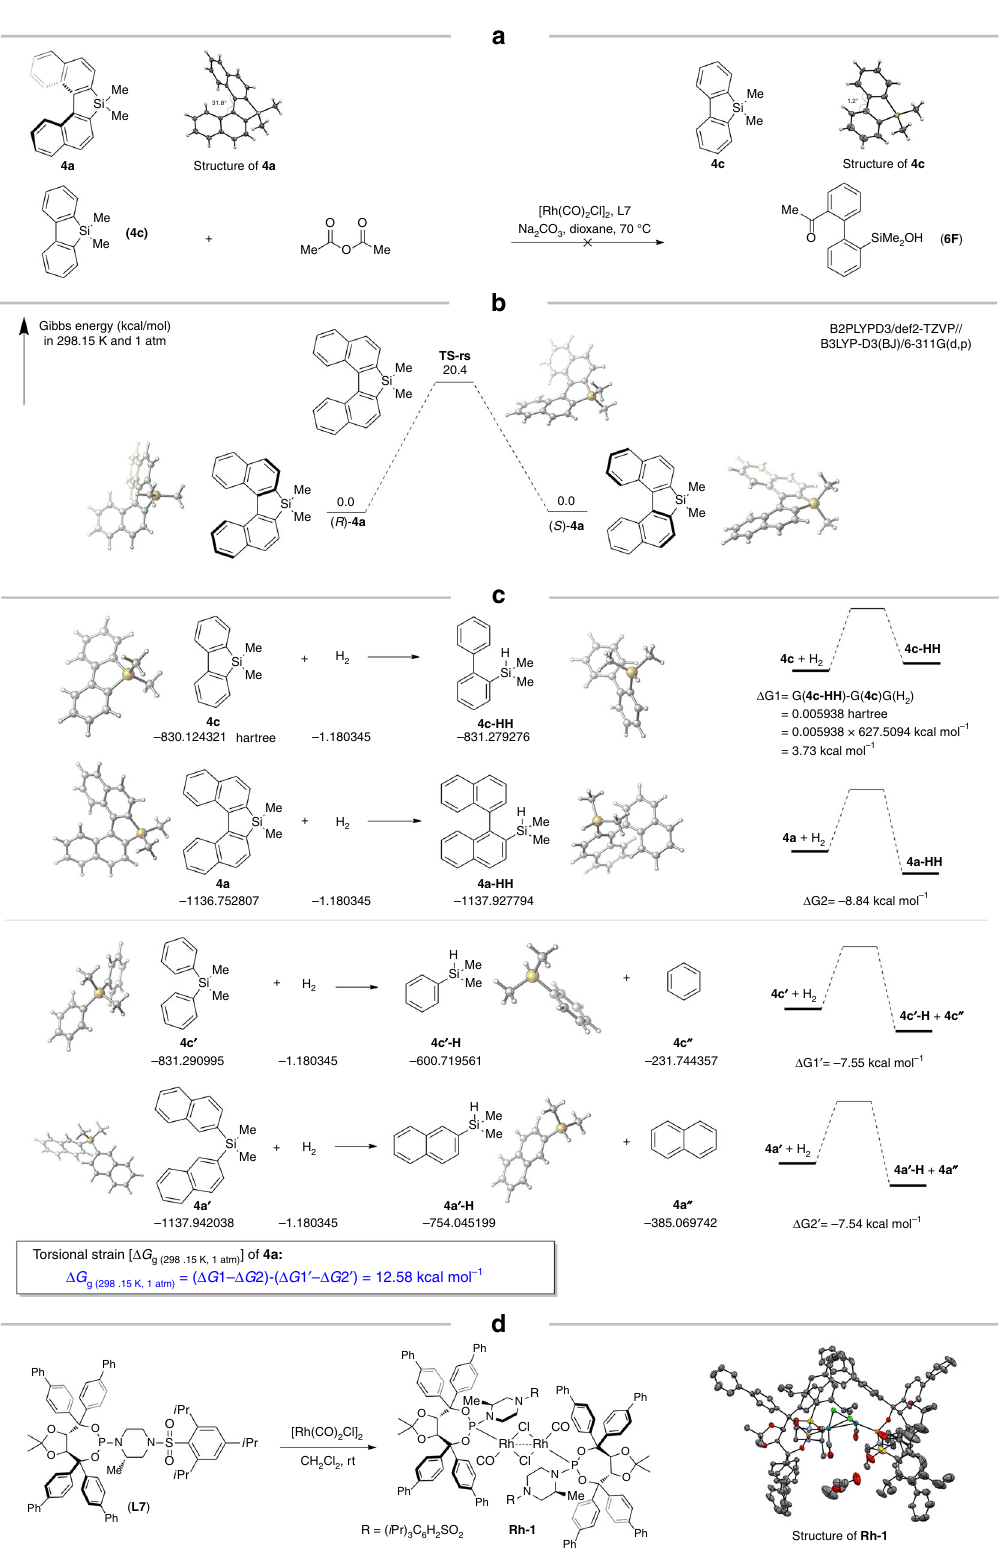
Fig. 6 Structure and activity relationship. a Relationship between structure and reactivity of sila fl uorene. b calculated rotational barrier energy of 4a . c Calculated torsional strain energy of 4a . d Preparation of Rhodium-ligand